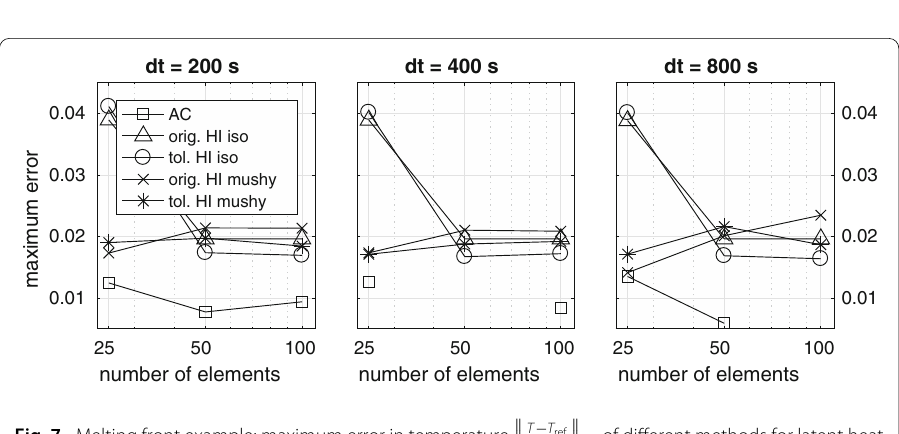
Fig. 7 Melting front example: maximum error in temperature depending on spatial and temporal discretization. Missing data points for the AC scheme indicate that no convergence was achieved for these parameter choices